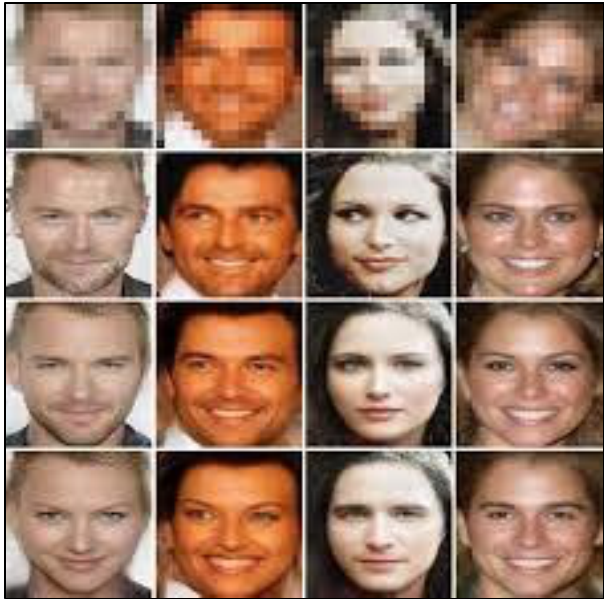
Figure 8. Low-resolution